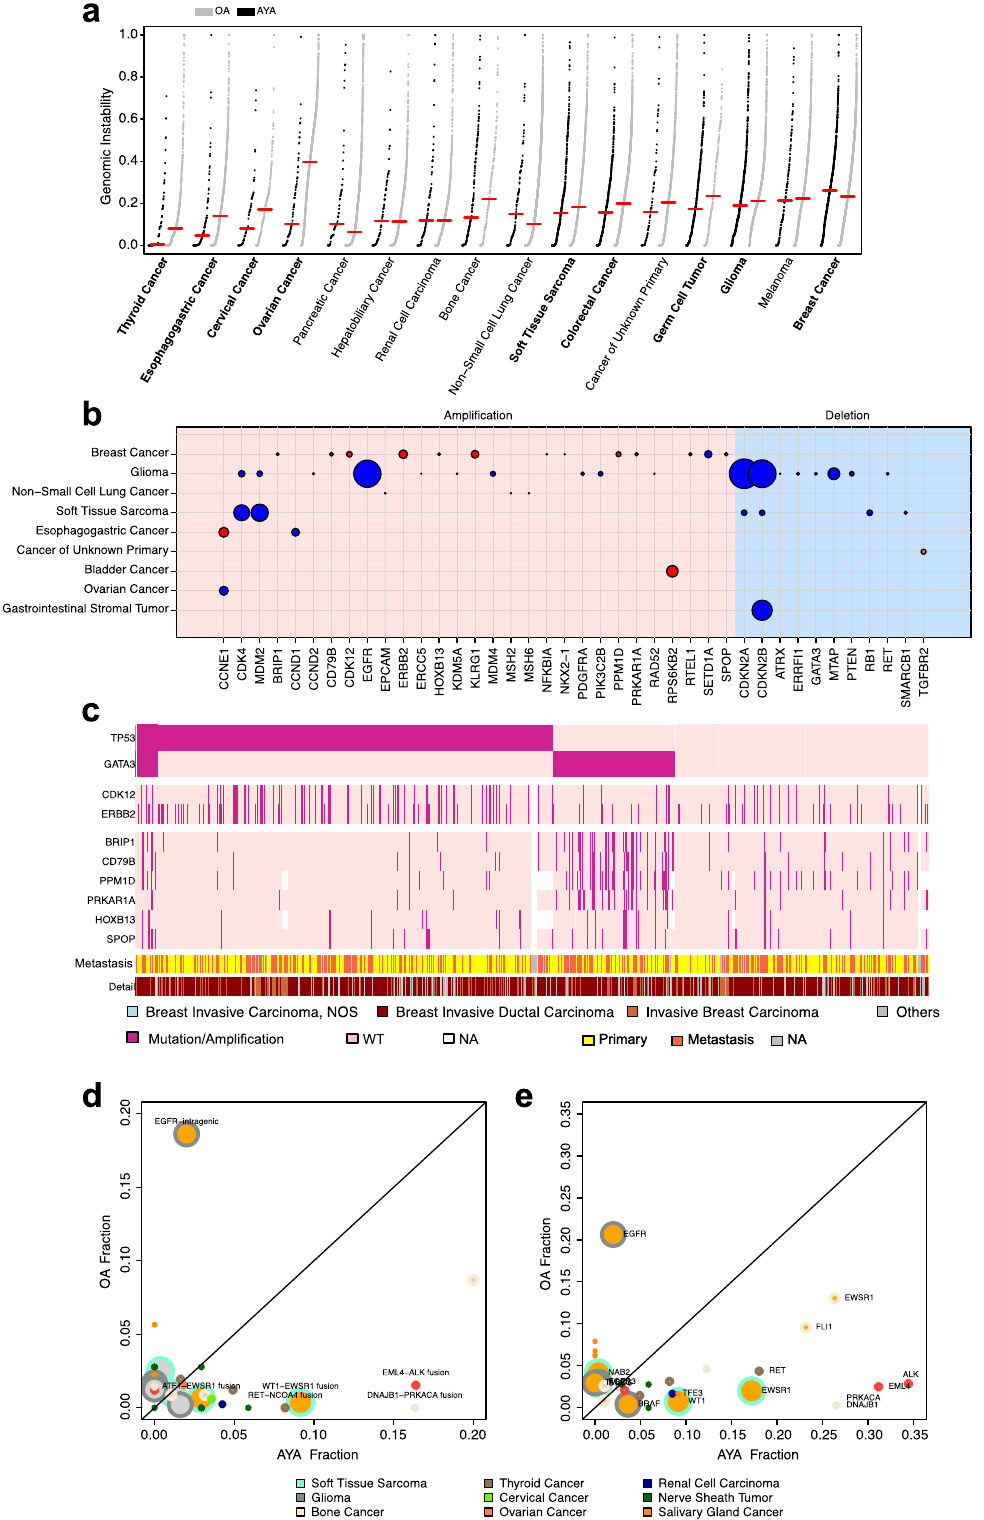
Fig. 3 | CNVs and fusions in AYAs. a Genomic instability (GI) scores in AYAs and OAs.CancertypesareorderedbymedianGIscore(red line)inAYAs.Cancertypes in bold font are statistically signi fi cant (FDR<0.05). b 46 gene level CNAs (left, ampli fi cation; right, deletion) that showed statistically different frequencies (FDR<0.05)betweenAYAsandOAs.Circlesizerepresentsdifferencesinalteration rate(AYA-OA).RedindicatestheCNVismorecommoninAYAs,andblueindicates